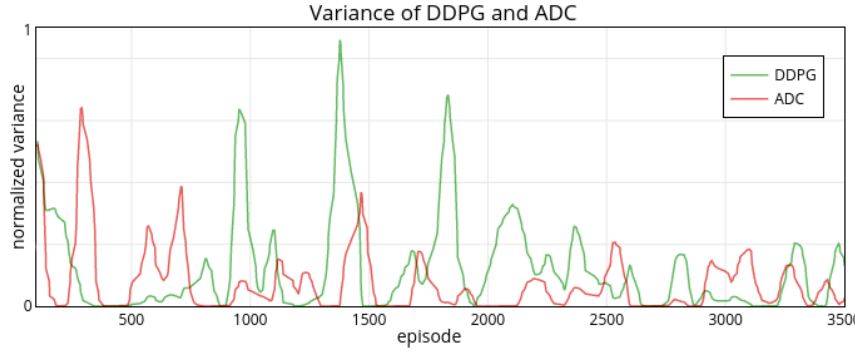
Figure 8. Variance of ADC and DDPG’s rewards.